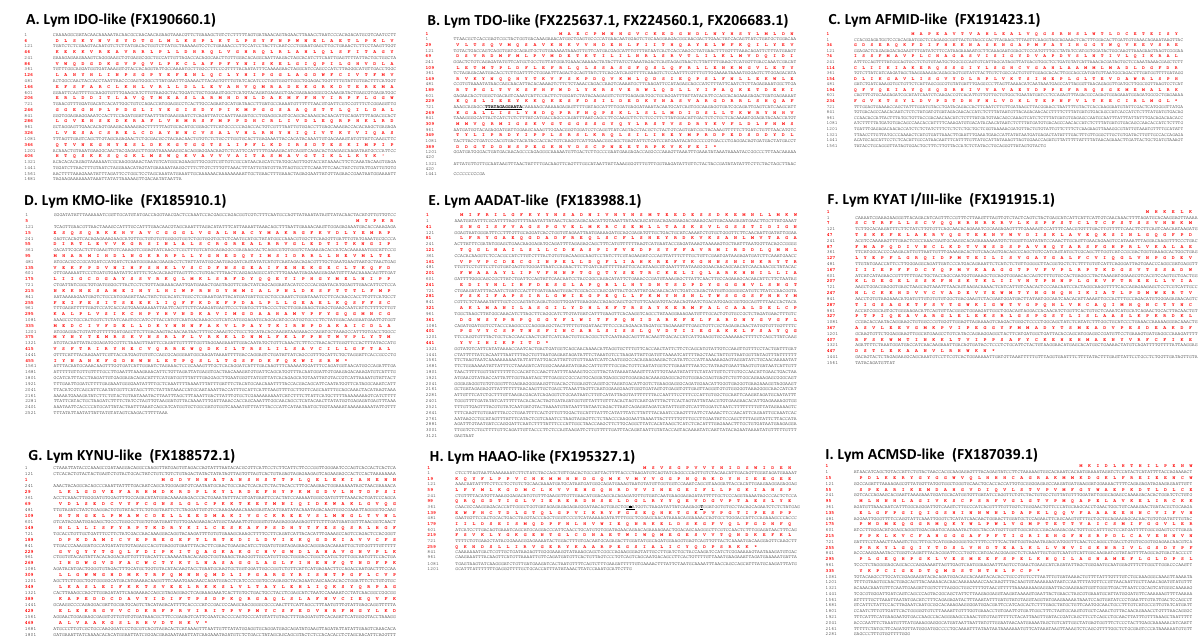
Figure 2. Nucleotide and deduced amino acid sequence of the putative enzymes of the KP pathway. ( A ) Lym IDO-like, ( B ) Lym TDO-like, ( C ) Lym AFMID-like, ( D ) Lym KMO-like, ( E ) Lym AADAT-like, ( F ) Lym KYAT I/III-like, ( G ) Lym KYNU-like, ( H ) Lym HAAO-like, ( I ) Lym ACMSD-like. Differences between the amplified and the deposited sequences are bold and californica , B. glabrata , P. canaliculata , and C. elegans 28 (Table 1). In C. elegans , we identified six orthologs that had an average homology of about 48% with the corresponding sequence of L. stagnalis . A similar degree of homology was found with mammalian sequences, while we observed a higher degree of homology with mollusk sequences (i.e., 63% for P. canaliculata , 64% for A. californica , and 70% for B. glabrata) . AADAT and ACMSD were the less (30% average homology) and the most (average homology of 71%) conserved genes, respectively (Table 1). This conservation pattern was also confirmed using multiple sequence alignment between each puta- tive enzyme identified in L. stagnalis and orthologues from other species (Fig. 3). Phylogenetic analyses revealed a predictable pattern in the relatedness of L. stagnalis sequences to those of other Mollusca (Fig. 4). Finally, the PFAM analysis confirmed that all the KP-predicted enzymes had the expected domains (Supplementary Fig. S2). Primer specificity, efficiency, and validation. qRT-PCR was used to evaluate the expression levels of the identified L. stagnalis KP-enzymes. All gene-specific primers for the analysis are shown in Supplementary Table S3. All primers produced consistent results without amplifying off-target products or generating primer dimers. Following amplification, each primer pair produced amplicons that yielded single bands at the cor- rect size after electrophoresis in 2% agarose gels (Supplementary Fig. S3). Additionally, no amplification was observed in cDNA from another pulmonated gastropod P. canaliculata or controls that lacked reverse tran- scriptase in the RT-PCR. Primer specificity was also checked by melt curve analysis. A single sharp peak with no primer-dimer was observed for all used primer pairs (Supplementary Fig. S4). Results showed that the PCR efficiency was between 94.82 and 125.30%, and the R 2 of primers was greater than 0.981. In addition, the mean Cq of all KP-enzymes ranged from 25.41 to 30.02 for 20 ng of cDNA with moderately abundant mRNA levels in the ganglia of L. stagnalis (Supplementary Table S3). Comparison of expression levels of KP-like enzymes among several tissues of L. stagnalis . We next evaluated the levels of L. stagnalis KP transcripts in the CNS and other tissues of the snail, such as the gut (i.e., digestive gland), stomach, muscle (foot), penis, and hemocytes ( n = 4 pools of 4 snails per each tissue). All KP-enzymes were ubiquitously transcribed in the L. stagnalis tissues with different relative abundance patterns (Fig. 5). Specifically, we found that Lym TDO-like was expressed at higher levels in the gut with respect to all the other tissues [F(5; 23) = 175.671; p < 0.0001]. Tukey’s post hoc test also revealed that the levels of Lym TDO- like mRNA in the muscle were higher than in SNC, stomach, and hemocytes. In contrast, Lym IDO-like was not differentially expressed in the considered tissues [F(5; 23) = 2.510; p = 0.068 with one-way ANOVA]. Lym AFMID-like mRNA levels in the gut and penis were significantly higher than in the stomach and hemocytes. No other difference was detected in any other tissue [F(5; 23) = 6.063; p = 0.002). The expression levels of Lym KMO- like in the CNS were significantly higher than those in the penis, gut, muscle, and hemocytes [F(5;23) = 29.639; p < 0.001]. Moreover, post-hoc analyses showed that the expression of this gene was significantly higher in the muscle than in all other tissues, while mRNA levels in the stomach were significantly higher than those in the hemocytes. The expression of Lym HAAO-like and Lym KYAT-like was significantly higher in the gut with